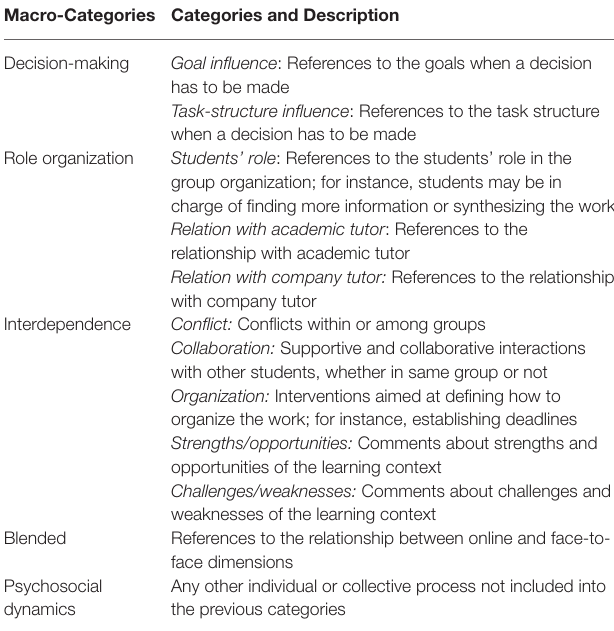
TABLE 2 | Analysis’